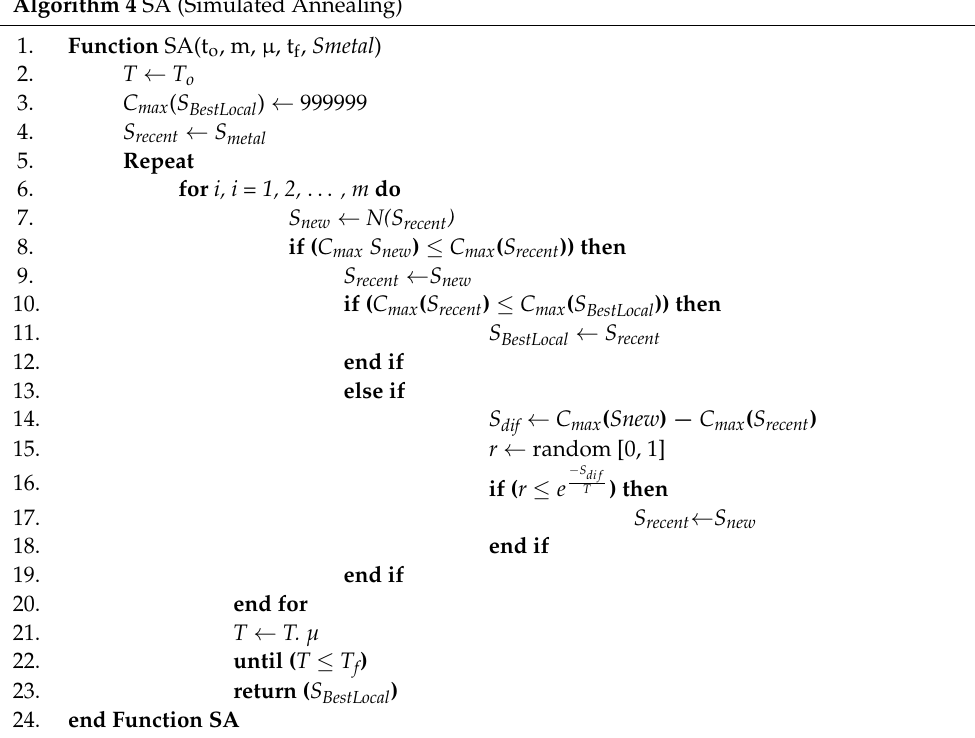
Algorithm 4 SA (Simulated